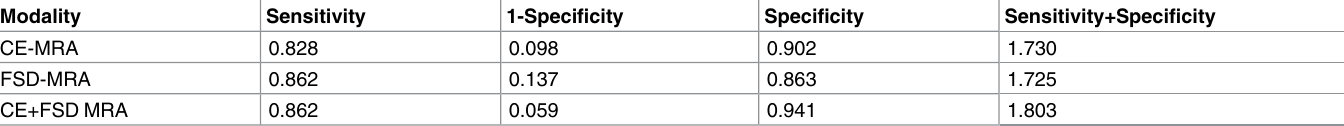
Table 6. Diagnostic accuracyof FSD-MRA, CE-MRA, and CE+FSD-MRA for detection of clinically significant stenosis, relative to DSA, with a ste- nosis degree cut-off value of 2.